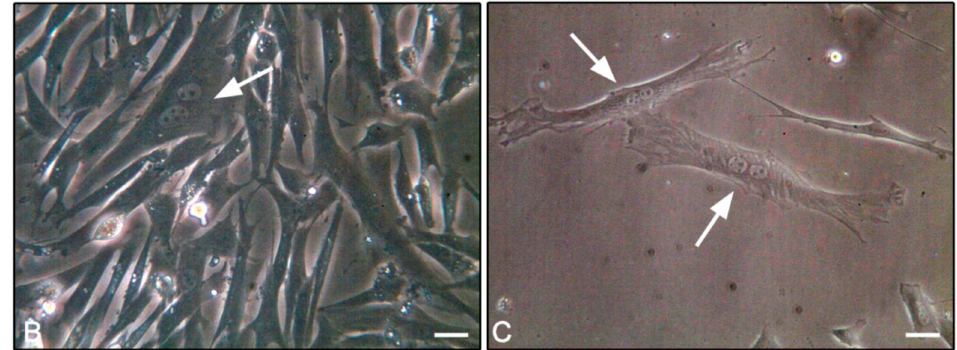
Figure 4. ( A ) Representative results of the cell cycle distribution of SfMSCs isolated from donors of di ff erent ages and measured by flow cytometry using propidium iodide staining. The percentage of the cell cycle the phase is shown in a bar graph form. A moderate gain of cells in the G0 / G1 phase and a decrease of cells in S phase is observed when comparing the 3Y group with the 40Y group. An increasing number of age-related tetraploid cells is observed. Number of events: cell frequency; propidium iodide: DNA staining fluorochrome. ( B ) Representative light microscope images of in vitro SfMSCs isolated from a 3-year-old equine donor showing the presence of tetraploid cells (white arrow) (bar: 30 µ m). ( C ) Representative light microscope image of in vitro SfMSCs isolated from a 40-year-old equine donor showing the presence of tetraploid cells (white arrows) (bar: 30 µ m). Table 3. Flow cytometry data of cell cycle distribution and frequency of tetraploid cells (4N) in SfMSCs isolated from equine donors of di ff erent ages.Values corresponding to each equine donor are reported and organized in the experimental group associated with age. The experiment was repeated in triplicate for each donor, and the results are expressed as percentage ± SD. a represents a significant di ff erence from 40Y group; p < 0.05. G0 / G1